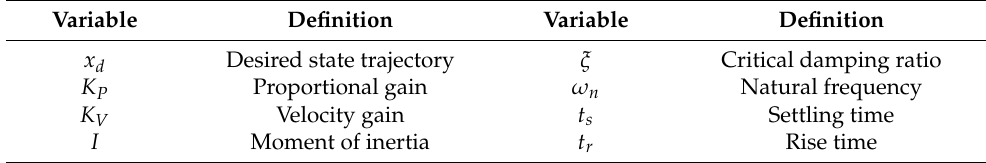
Table 1. Proximal variable